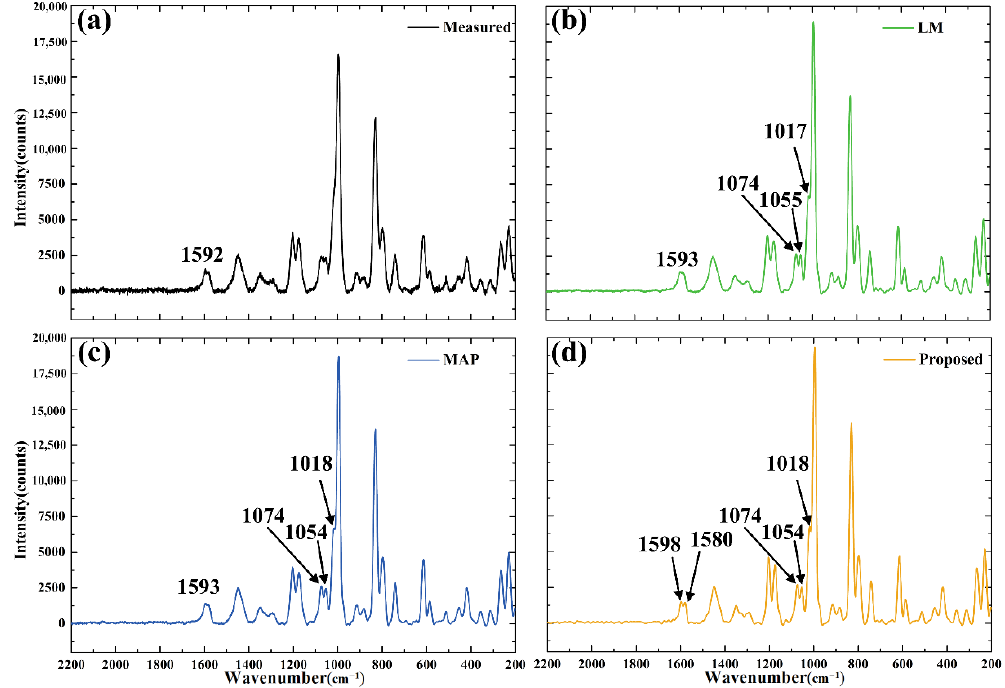
Figure 10. ( a ) Methamphetamine (C 10 H 15 N) measured spectrum and reconstructed spectra with spectral range from 2200 to 200 cm −1 by ( b ) the LM method; ( c ) the MAP method; ( d ) the proposed method.